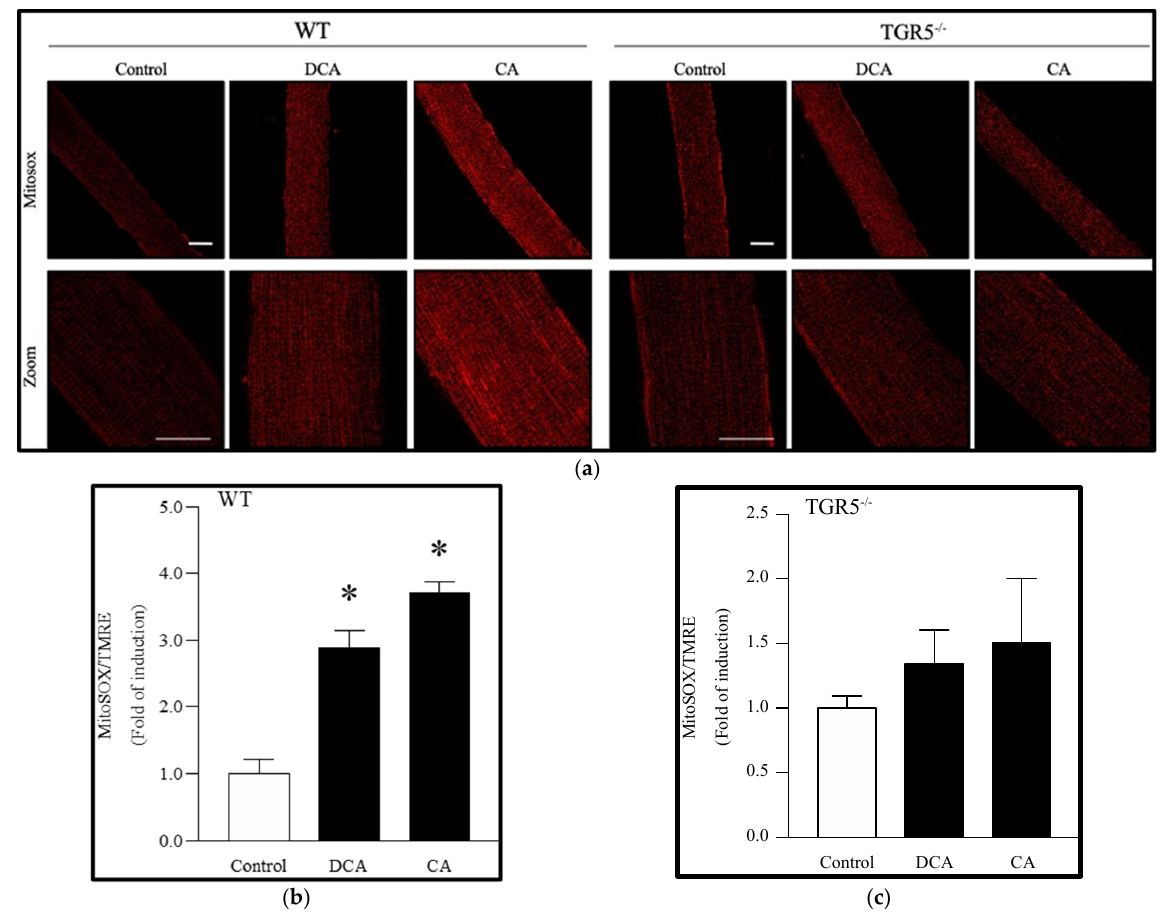
Figure 6. Increased mitochondrial reactive oxygen species (ROS) levels induced by deoxycholic acid (DCA) and cholic acid (CA) in muscle fibers involve a TGR5-dependent mechanism. Skeletal muscle fibers from WT and TGR5 − / − mice were incubated with DCA or CA for 72 h. Then, fibers were incubated with a Mitosox probe. ( a ) Representative images for the Mitosox signal (upper panel, lower panel zoom). Scale bar = 20 µm. ( b , c ) Analysis of the Mitosox signal normalized by the TMRE signal in WT ( b ) or TGR5 − / − ( c ) fibers. Values are expressed as the fold of induction and correspond to the means ± SEM ( n = 3, * p < 0.05 vs. control condition; one-way ANOVA and Tukey’s multiple comparison test).